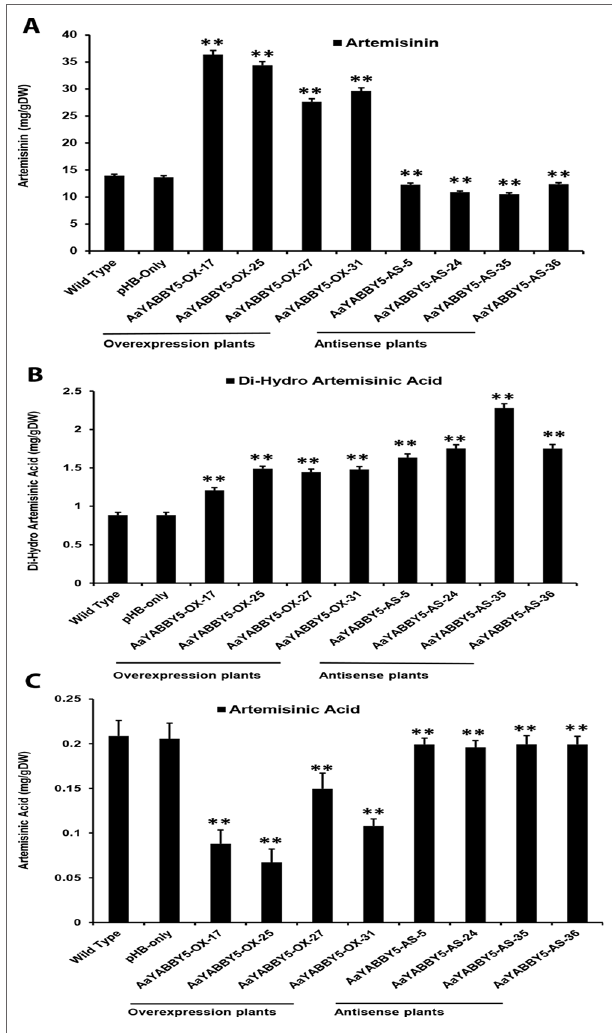
FIGURE 8 | High-performance liquid chromatography (HPLC) analysis of metabolites in AaYABBY5 overexpression and antisense plants. The concentration of (A) artemisinin, (B) dihydroartemisinic acid, and (C) artemisinic acid in AaYABBY5 overexpression and antisense plants of Artemisia annua. Values of all metabolites represent mean ± SD of three independent experiments. Error bars represent the standard deviation for n = 3. Statistical significance was determined by Student’s t -test with paired and two-tailed distribution methods. Asterisks indicate the difference between transgenic and control plants. ** P <